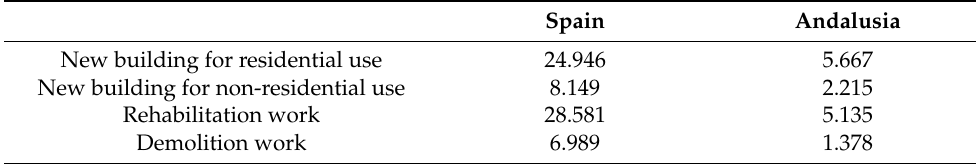
Table 3. Number of buildings according to construction type. Spanish Ministry of Development